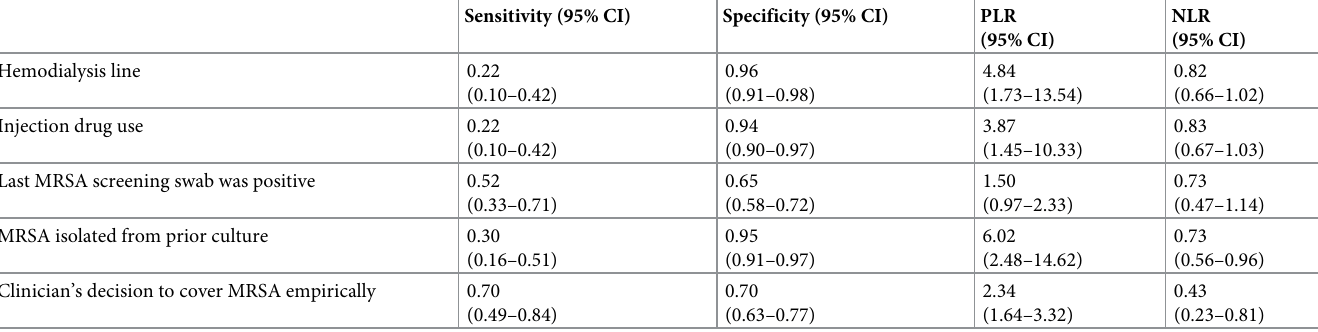
Table 5. Diagnostic accuracy of patient risk factors and clinician’s decision on empiric Vancomycin in predicting MRSA